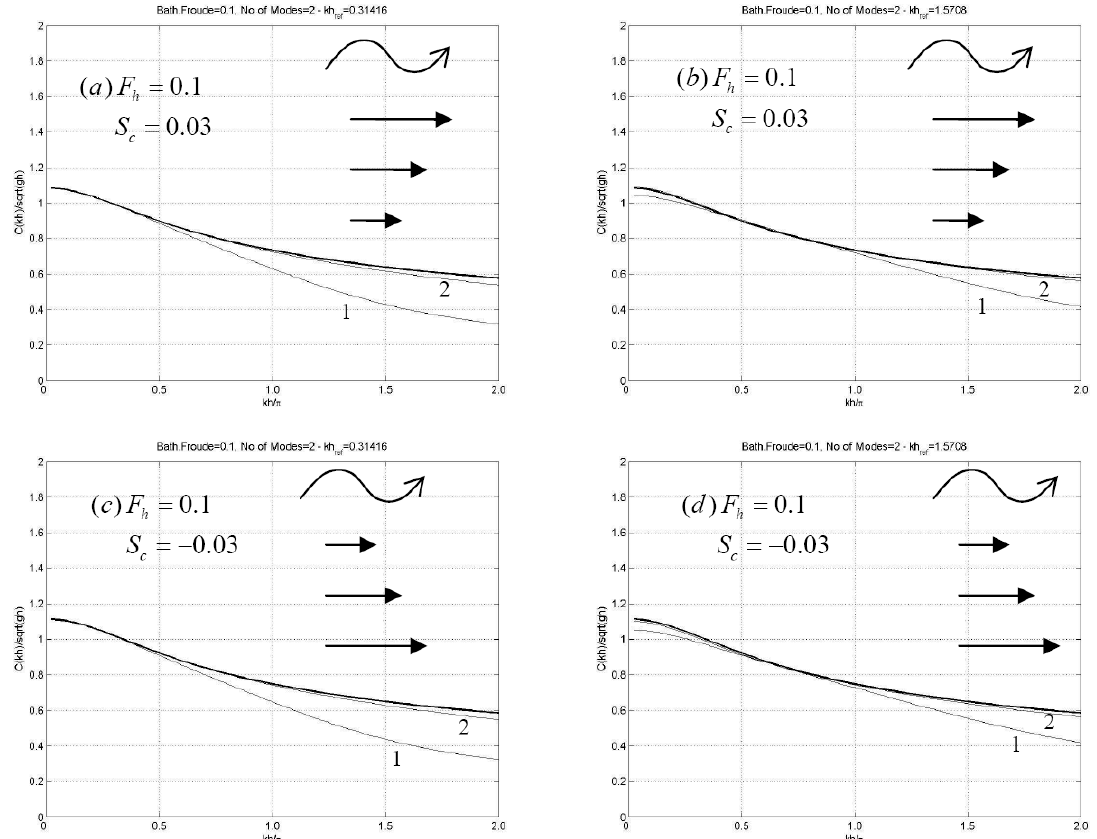
Figure 5. Dispersion characteristics of the linearized CMS in the case of waves and following shear current with constant vorticity in constant depth strip, using one term ( n = 0, indicated by 1), and two terms ( n = 0,1, indicated by 2) in the local mode expansions; ( a , c ) µ 0 h = 0.1 π , ( b , d ): µ 0 h = 0.5 π . The specific values of F h and S c are included in the subplots.